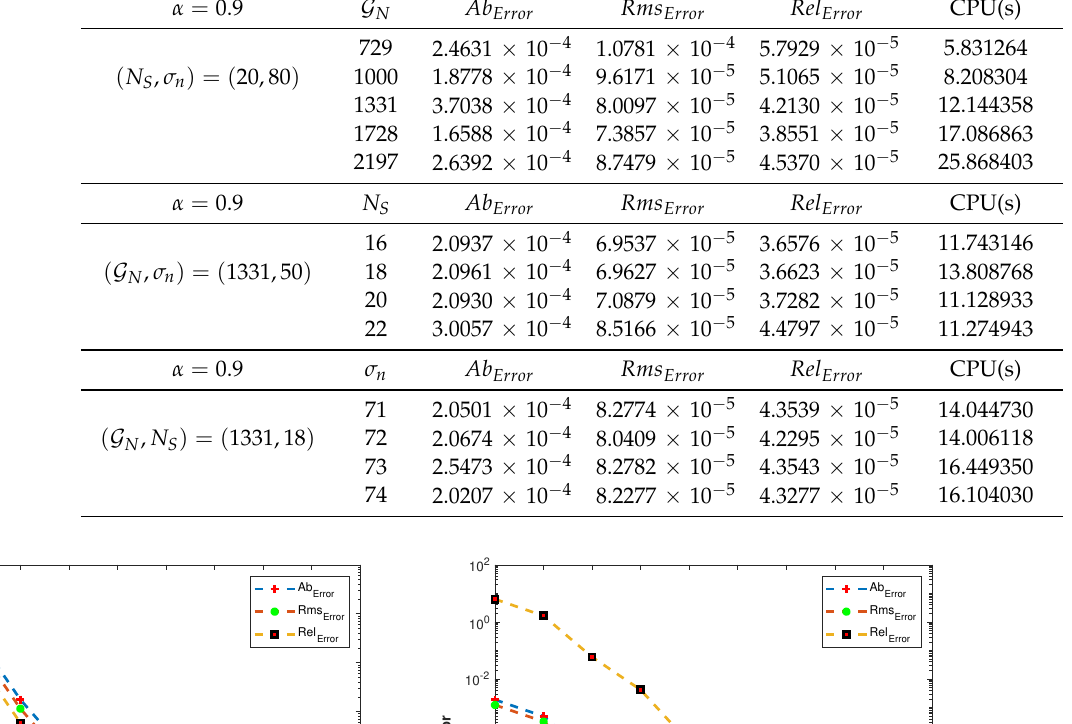
Table 4. The errors obtained using the proposed scheme at final time T = 1 for problem 4.